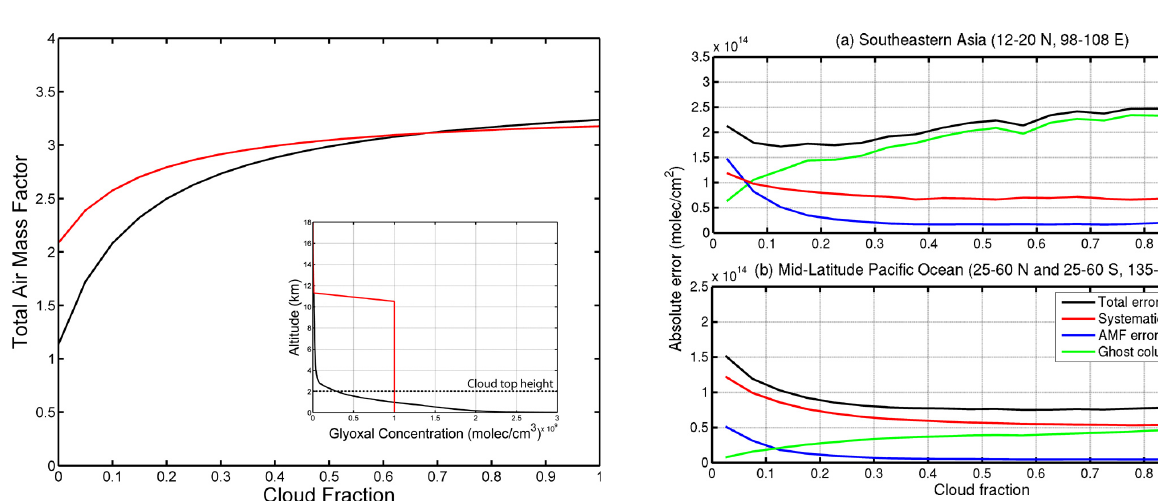
Fig. 7. Cloud fraction dependence of the total air mass factor cal- culated with a glyoxal profile strongly peaking at the surface (black curve) or with an unrealistic constant glyoxal profile in the tropo- sphere (red curve). The corresponding profiles are plotted in the inner figure and the peaked profile is provided by the model IM- AGESv2 for the region of Beijing on 1 July 2007. In these AMF calculations, the SZA is 50 ◦ , the surface albedo is 0.03 and the top height of the Lambertian cloud is 2km (dashed line in the inner figure).